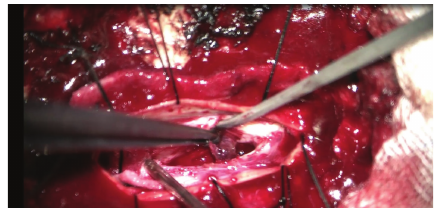
Figure 3: Intraoperative findings showing the hematoma after